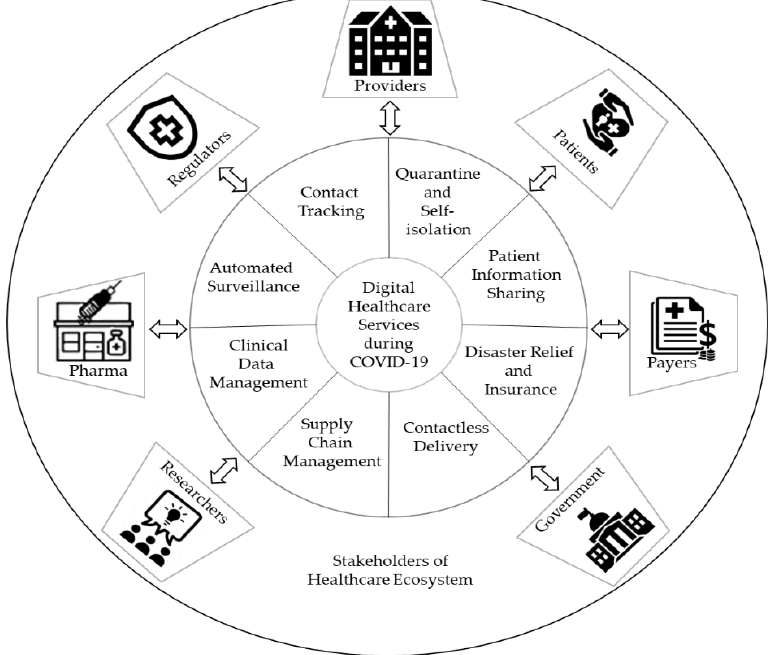
Figure 1. Healthcare ecosystem and digital services for pandemic preparedness and response during COVID-19.